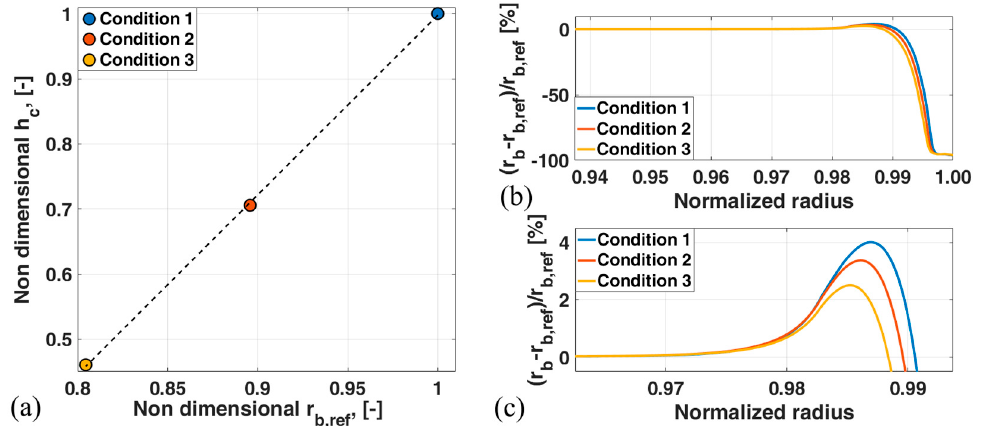
Figure 16. Convective heat transfer coefficients and burn rate increments for different conditions: ( a ) averaged values of nondimensional convective heat coefficient vs nondimensional reference burn rate; ( b ) percentage variation of local burn rate with respect to the reference one vs normalized radius for different conditions; ( c ) zoom of the percentage variation of local burn rate with respect to the reference one for different conditions in the tail-off region.